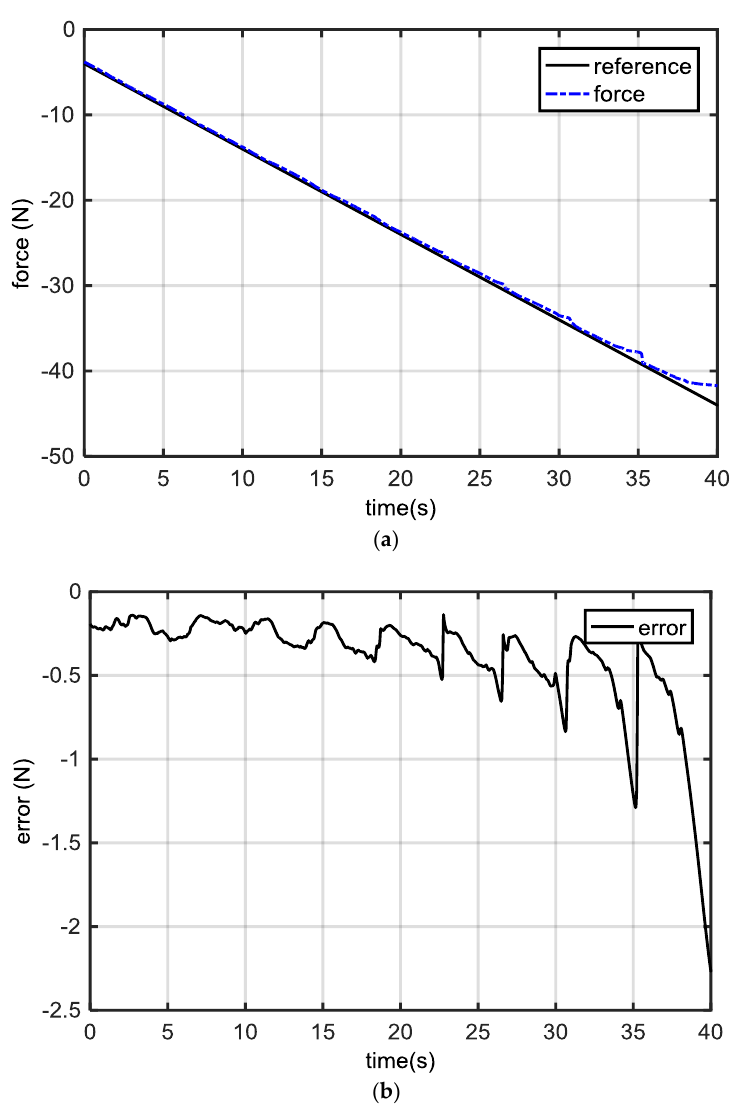
Figure 7. Dynamic response under unit ramp ( a ) force profiles ( b ) error waveforms.